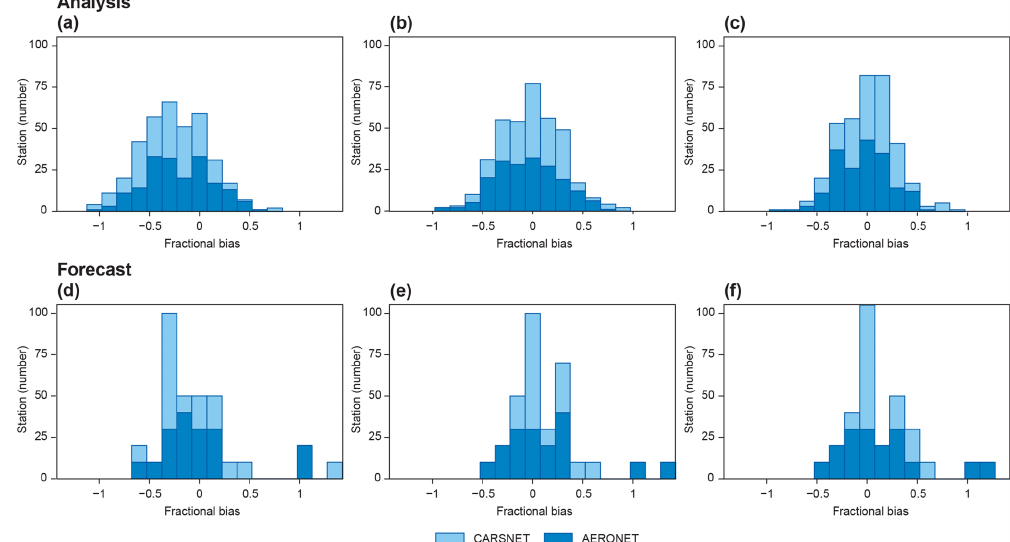
Figure 8. The histograms on the top and bottom rows are constructed using data from all stations displayed in the map of Fig. 4 and are valid at the analysis and 48h forecast times, respectively. Panels (a) and (d) are relative to the experiment CONTROL, (b) and (e) to the experiment DT and (c) and (f) to the experiment